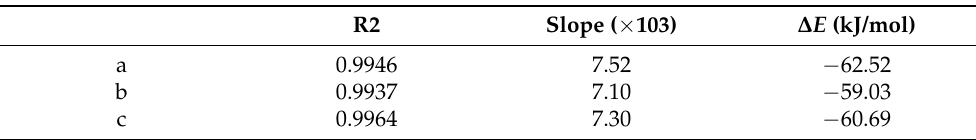
Figure 5. Plots of ln( a / T 2 max ) versus 1/ T max according to the Kissinger equation of ( a ) PEG in method 1, ( b ) PEG in PEG-PLLA in method 1 and ( c ) PEG in PEG-PLLA in method 2. Table 3. The fitting results of Kissinger equation (a) PEG in method 1, (b) PEG-PLLA in method 1 and (c) PEG-PLLA in method